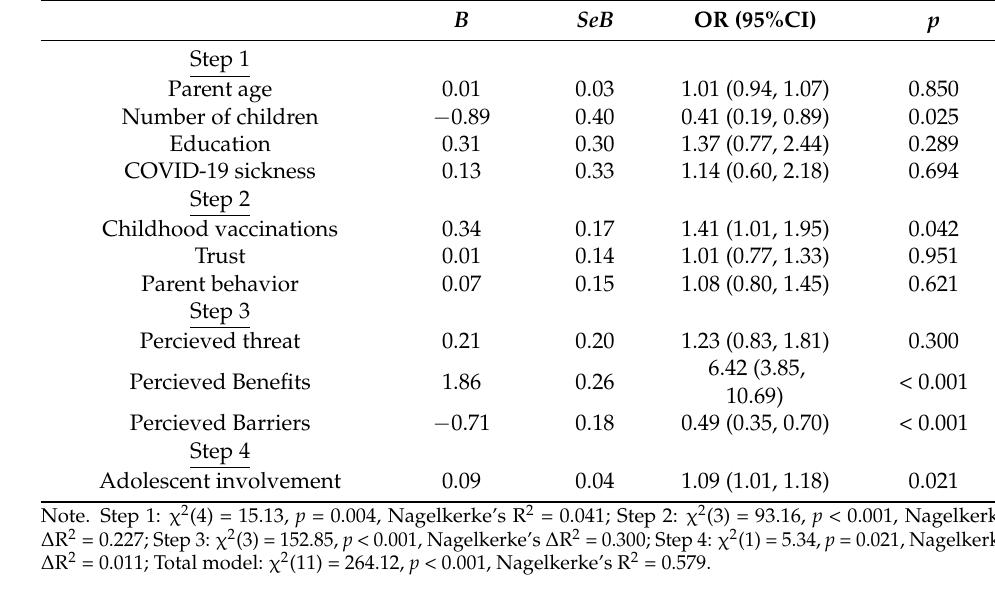
Table 2. Logistic regression model for adolescent vaccination against COVID-19 with background variables, HBM variables, and adolescent’s involvement in the decision-making process ( n = 581).